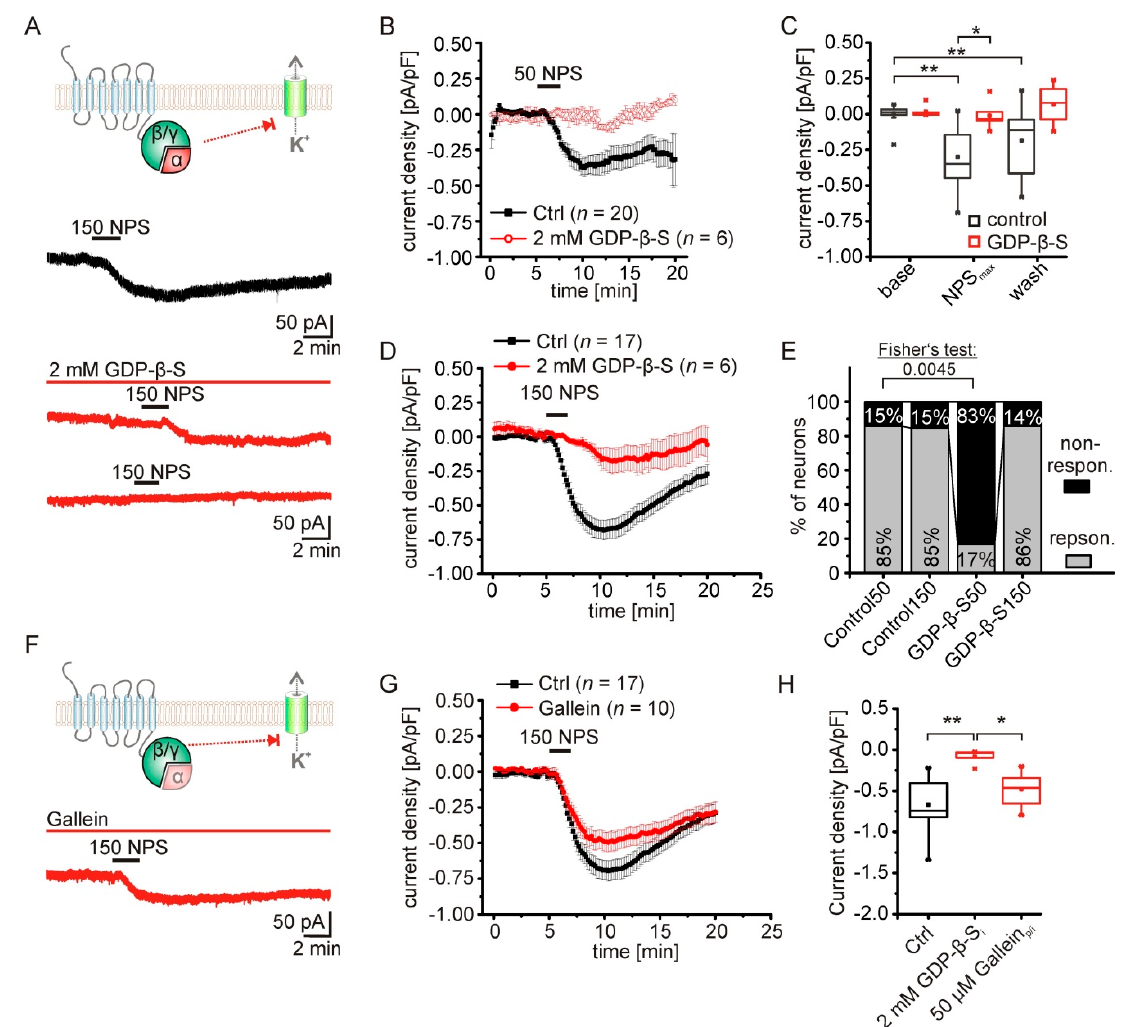
Figure 3. The NPS-induced current is dependent on NPSR1-G α -signaling. ( A ) To differentiate between G-protein-dependent and direct GPCR-effector interactions leading to changes of potassium conductances, GDP- β -S was used to inhibit intracellular G protein signaling. Example traces show the NPS-induced current during control conditions and with 2 mM GDP- β -S in the intracellular solution. Examples of responding and nonresponding neurons are depicted. ( B ) Time course of mean current densities during control conditions, and in the presence of GDP- β -S. NPS (50 nM) was bath applied for 2.5 min. Of note, the mean current density in the presence of GDP- β -S was calculated from responsive and nonresponsive neurons, since 50 nM NPS elicited a detectable current in only one of six recorded neurons (E). For comparison, nonresponsive neurons of the control were included in the analysis here. ( C ) Statistical analysis reveals a lack of effect in GDP- β -S treated neurons upon application of 50 nM NPS. ( D ) Time course of mean current densities during control recordings, and in presence of 2 mM GDP- β -S. NPS (150 nM) was applied for 2.5 min. ( E ) Fractions of responsive and nonresponsive neurons during control conditions (50 nM or 150 nM NPS), and in the presence of GDP- β -S (50 nM or 150 nM NPS). In the presence of GDP- β -S, 50 nM NPS fails to evoke a detectable current compared to control conditions. ( F ) To test for a possible role of the G β / γ -subunits, the subunit-specific inhibitor gallein (50 µM) was used. Example trace shows an NPS-evoked current in the presence of gallein. ( G ) Time course of NPS-dependent currents during control conditions, and in presence of 50 µ M gallein. ( H ) Quantification of mean maximal current densities evoked by 150 nM NPS in the presence of GDP- β -S or gallein compared to the control. * p < 0.05; ** p <